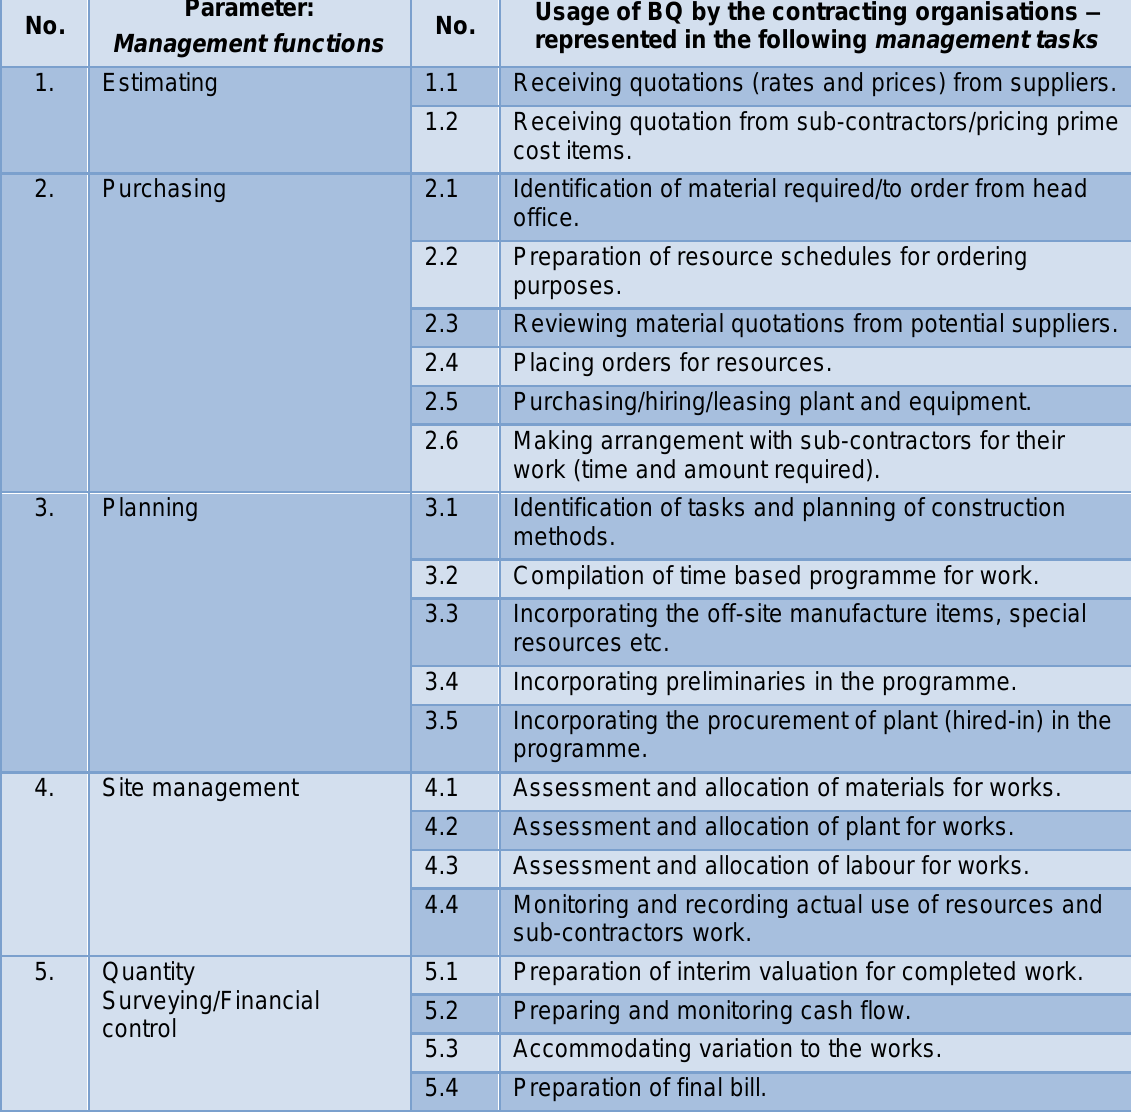
Table 5: The usage of the BQ by the contracting organisations by Kodikara (1990) and Kodikara, et al. (1993) Source: adapted from Kodikara (1990, p. 121) and Kodikara, et al. (1993, p.